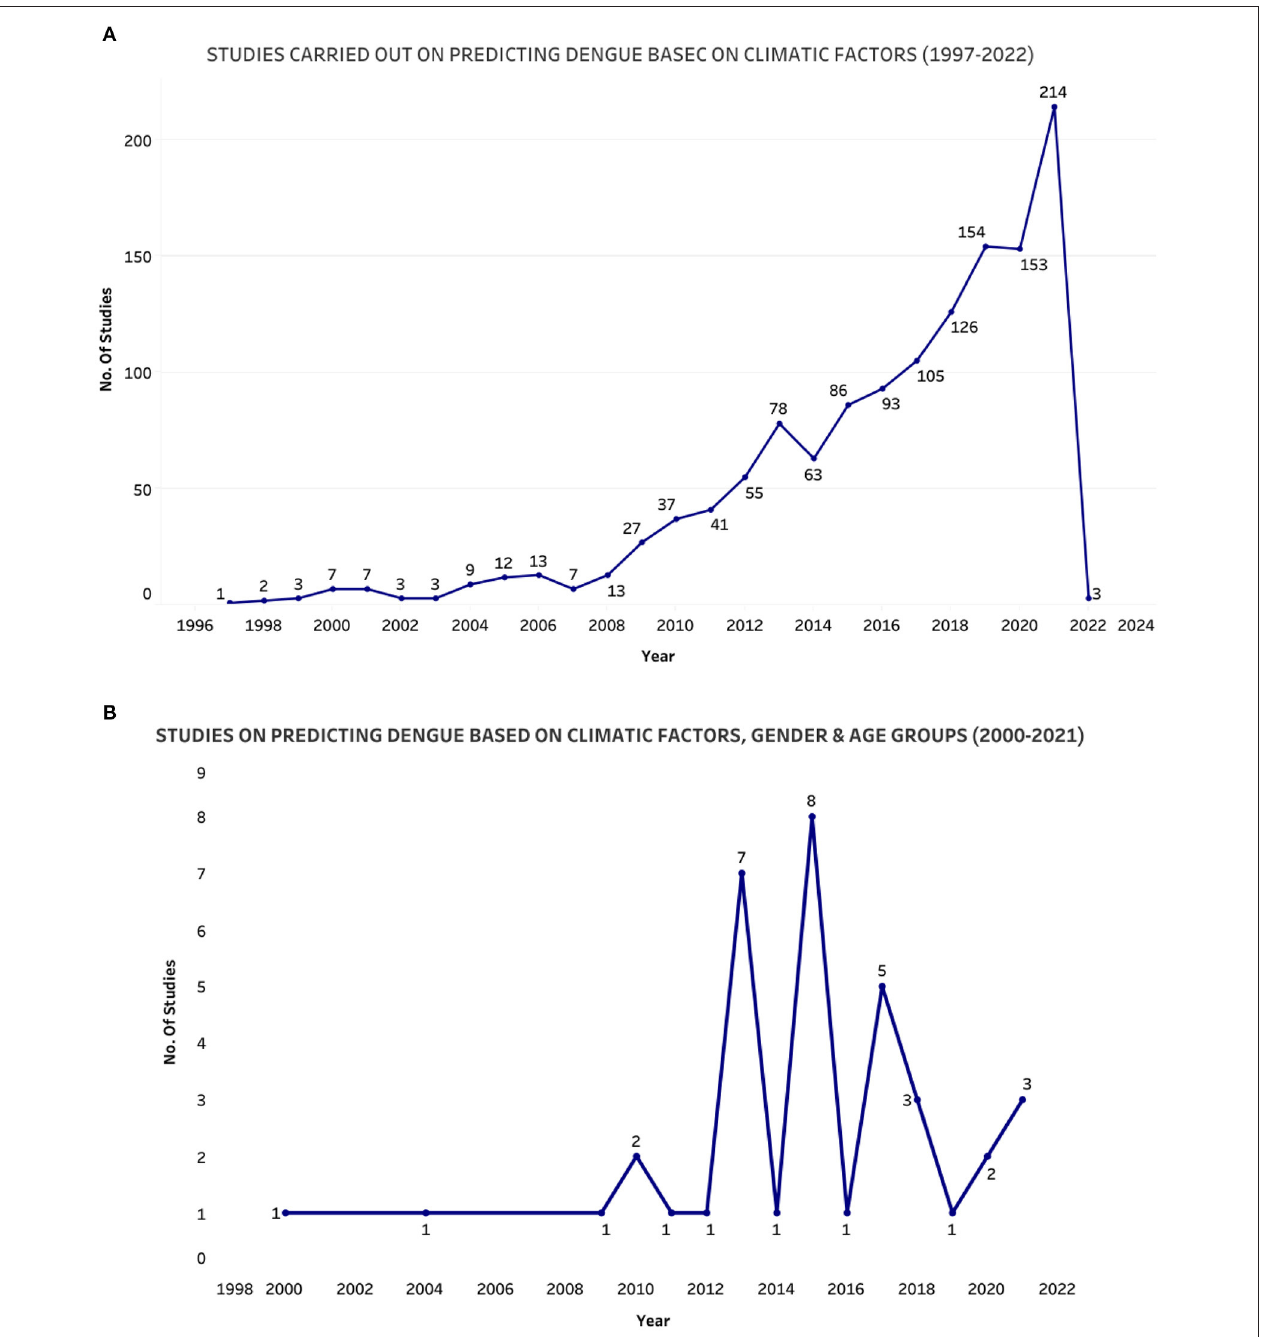
FIGURE 5 | No. of studies in different regions and time-period of scopus database: (A) No. of studies carried out on predicting dengue based on climatic factors for the time period 1997–2022 and (B) No. of studies carried out on predicting dengue based on climatic factors, age group and gender for the time-period 2000–2021.